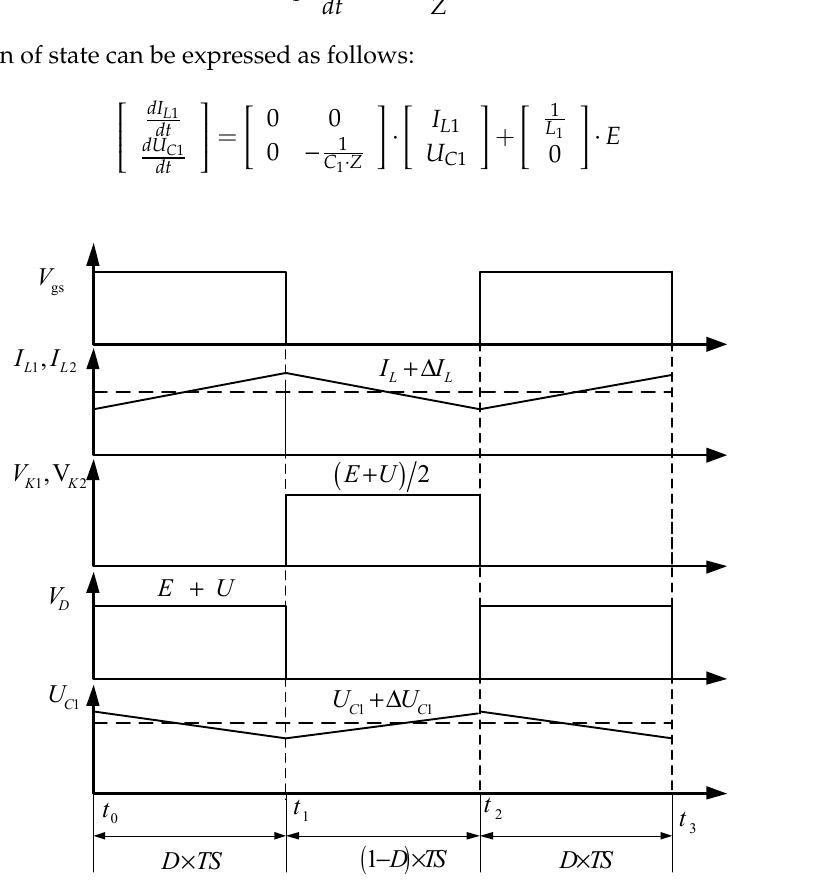
Figure 5. Working waveform of dual-switch boost converter.